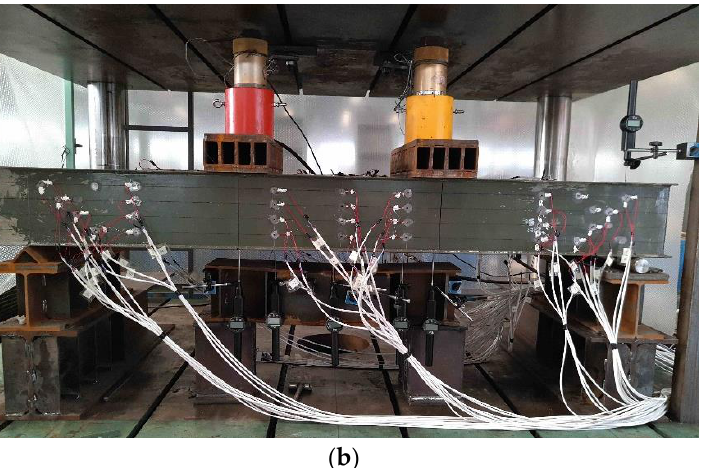
Figure 4. Loading device and displacement meter arrangement: ( a ) Loading schematic; ( b ) Loading site.